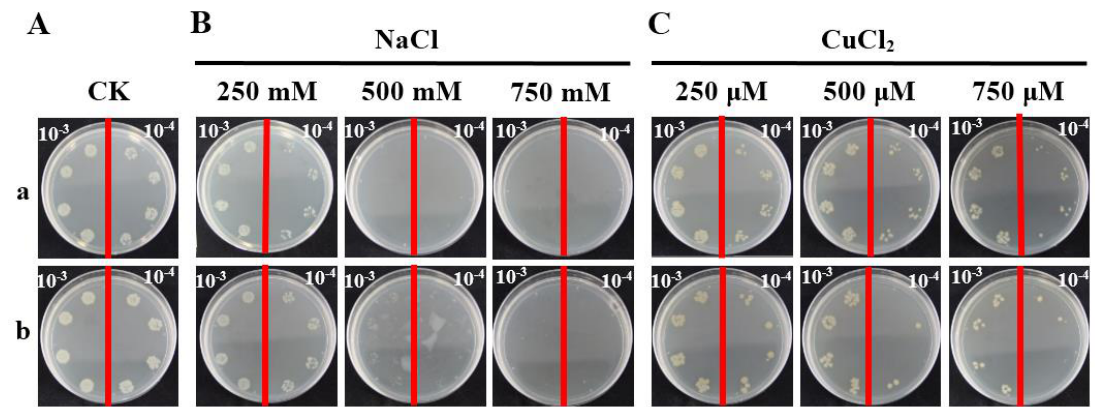
Figure 8. Spot assay of Rosetta + pET-32a (control) ( a ) and Rosetta + pET-32a- ScCAT2 ( b ) on LB plates with different concentrations of NaCl and CuCl 2 components. The cultures of Rosetta + pET-32a- ScCAT2 and Rosetta + pET-32a were supplemented with 1.0 mM isopropyl β - D -thiogalactoside to induce the expression of recombinant protein overnight. Then, the cultures were adjusted to an OD 600 = 0.6. Ten microliters from the 10 − 3 (left side of red line on plate) to 10 − 4 (right side of red line on plate) dilutions were spotted onto the LB basal plates ( A ) or with NaCl (250, 500, and 750 mM) ( B ), and CuCl 2 (250, 500, and 750 μM) ( C ). NaCl, sodium chloride; and CuCl 2 , copper chloride.